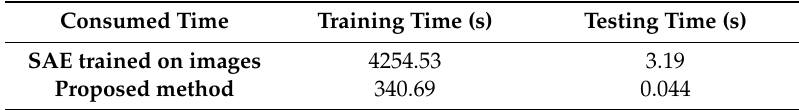
Table 7. Training time and testing time of different